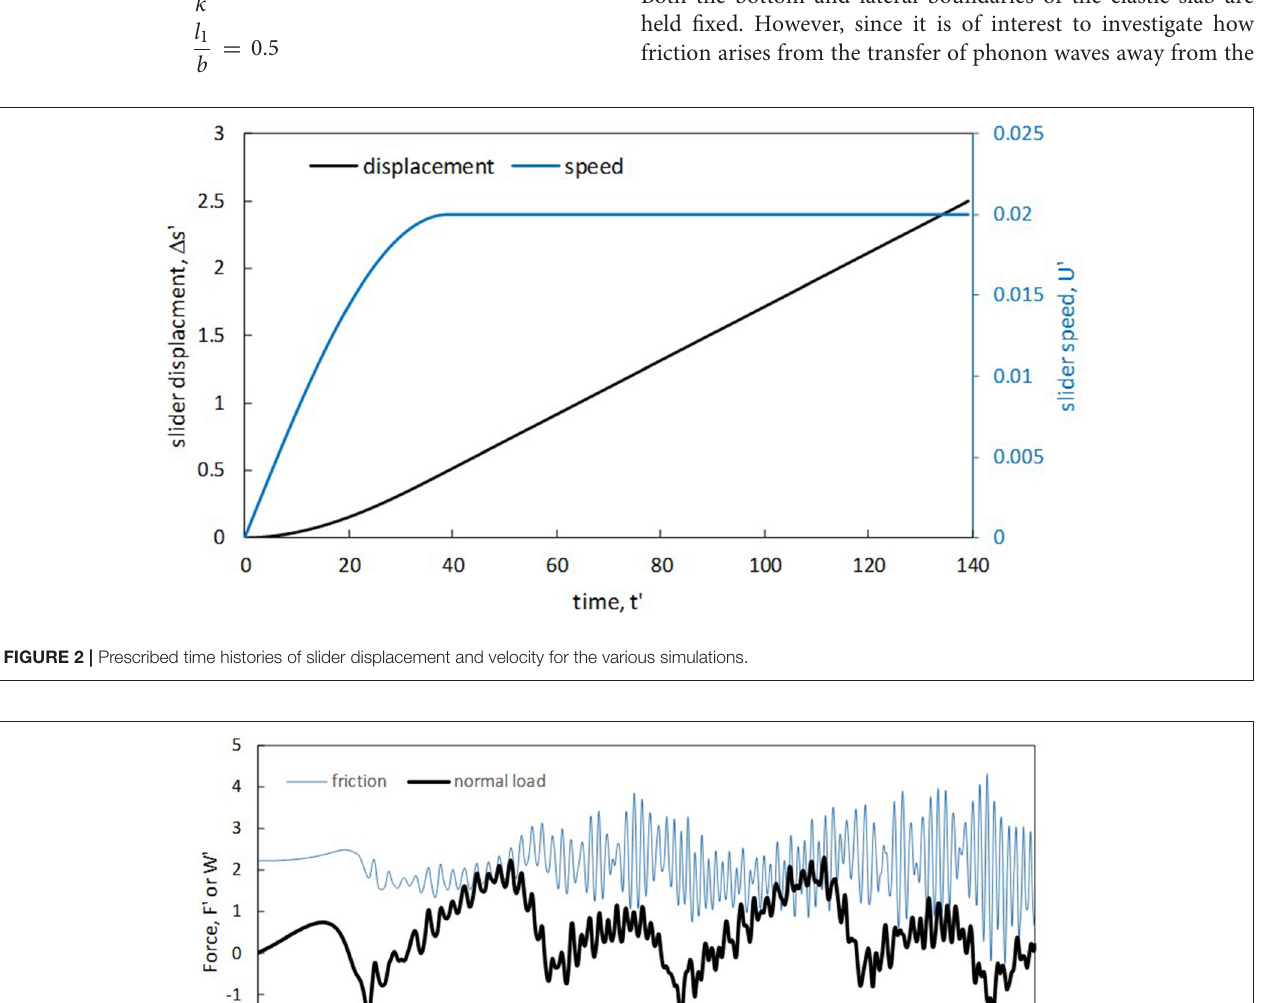
Frontiers in Mechanical Engineering |